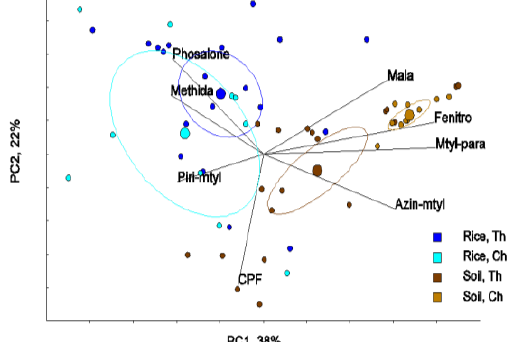
Figure 5. Principal component analysis (PC1, PC2) of organophosphorus (OPPs) in rice and soil from Thailand and China: malathion (mala), fenitrothion (Fenitro), methyl parathion (Mtyl-para), azinphos methyl (Azin-mtyl), chlorpyrifos (CPF), phosalone (phosalone), methidathion (methida), pirimiphos methyl (Piri-mtyl), rice of Thailand (Rice, Th), rice of China (Rice, Ch), soil of Thailand (Soil, Th), soil of China (Soil, Ch).